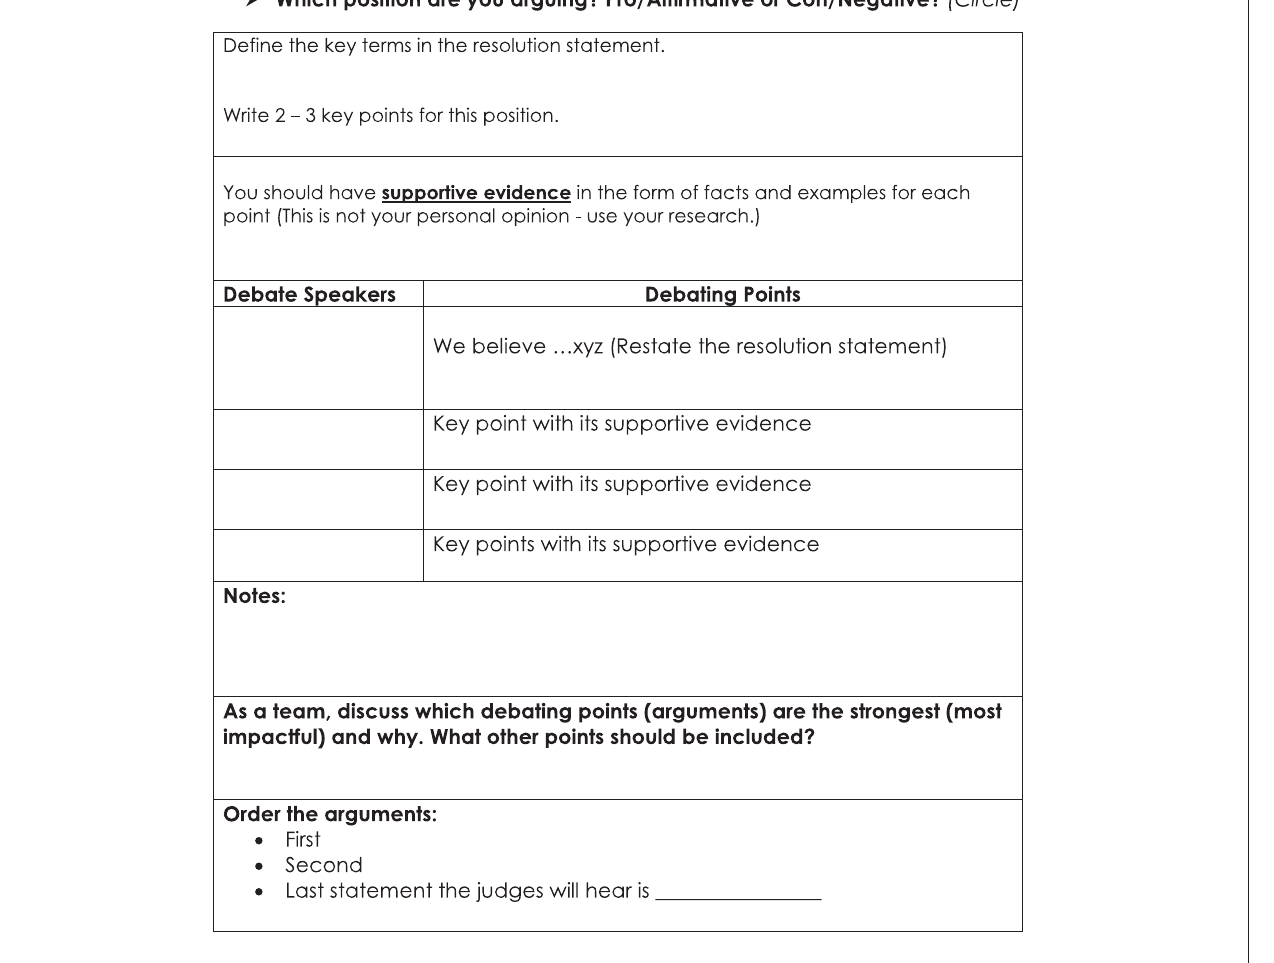
FIGURE 3 | Team Guided Notes